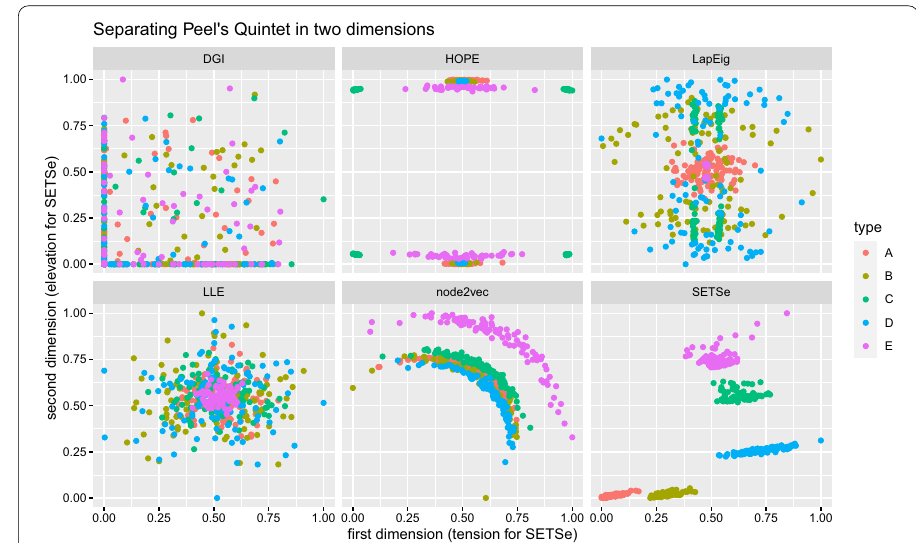
Fig. 4 One hundred examples of each of the five network classes of Peel’s quintet introduced by Peel et al. (2018). The networks are clearly linearly separable in the averaged SETSe space even though all 500 are identical using assortativity